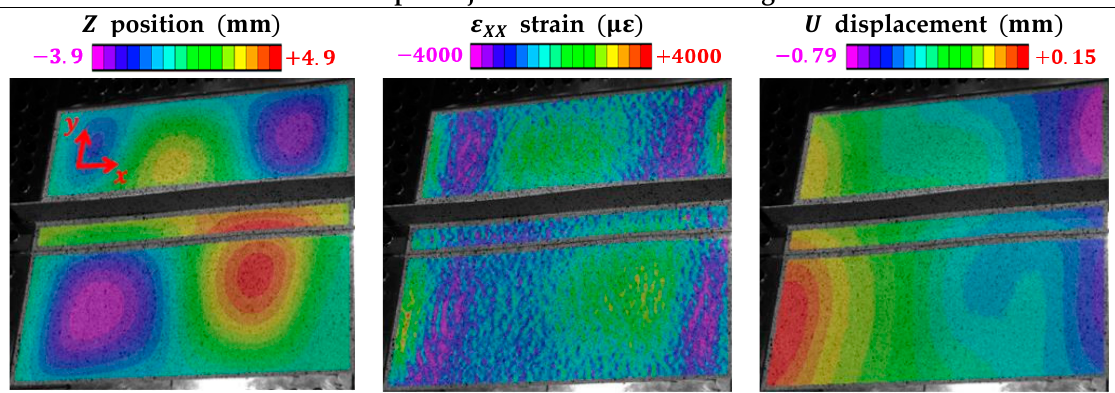
Figure 21. Points of view of the two pairs of cameras used for stereo-correlation, looking down onto Sample1 between the first debonding and the main debonding-tunnelling.